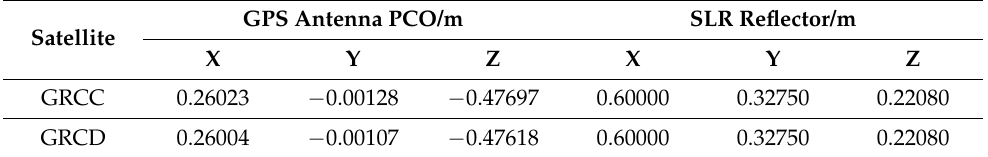
Table 2. GPS antenna PCOs and SLR reflector Coordinates of GRACE-FO